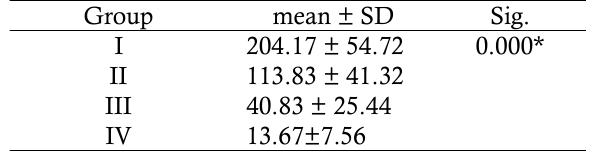
Figure 1 . Histopathological features of kidney in formaldehyde-exposed rats at different treatment groups: (A) group I (formaldehyde only); (B) group II (formaldehyde and 100 mg/ kg BW meniran ); (C) Group III (formaldehyde and 200 mg/ kg BW meniran ); (D) Group IV (formaldehyde and 300 mg/ kg BW meniran ). Yellow arrow shows albuminous degeneration, black arrow shows hydropic degeneration, green arrow shows fat degeneration, and white arrow shows necrotic /apoptotic cells. Table 1. The mean of cell damage number ( D ) of kidney in the various groups Group Mean ± SD Sig. Figure 2. Histopathological features of liver in formaldehyde-exposed rats at different treatment groups: (A) group I (formaldehyde only); (B) group II (formaldehyde and 100 mg/ kg BW meniran ); (C) Group III (formaldehyde and 200 mg/ kg BW meniran ); (D) Group IV (formaldehyde and 300 mg/ kg BW meniran ). Yellow arrow shows albuminous degeneration, black arrow shows hydropic degeneration, green arrow shows fat degeneration, and white arrow shows necrotic/apoptotic cells. (*) Kruskal Wallis results shows a difference among groups at 5% significance level Table 2. The mean of cell damage number (D) in liver of rats exposed to formaldehyde of different groups Group mean ± SD Sig. 204.17 ±